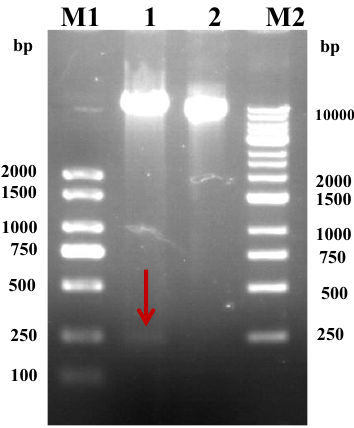
Figure 4. Analysis of the recombinant plasmid pPIC9K-hirudin through double enzyme digestion (Lane M1; Marker 2000; Lane 1: recombinant plasmid digested with EcoRI and NotI; Lane 2: recombinant plasmid; Lane M2: Marker DL 10,000). The target gene is indicated using a red arrow (217 bp). The products were analyzed on a 1% agarose gel. The original gel is presented in Fig. S2.